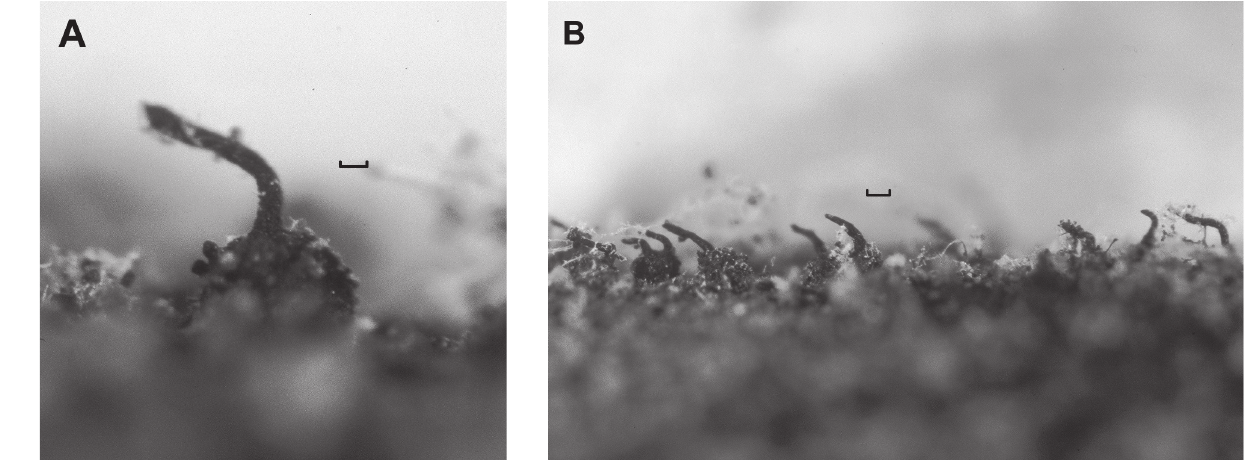
Fig. 2. Ascomata of Togninia minima on moist incubated grapevine wood. A. Single ascoma. B. Group of ascomata showing probable phototropic alignment. Scale bars: A = 50 µm; B = 100